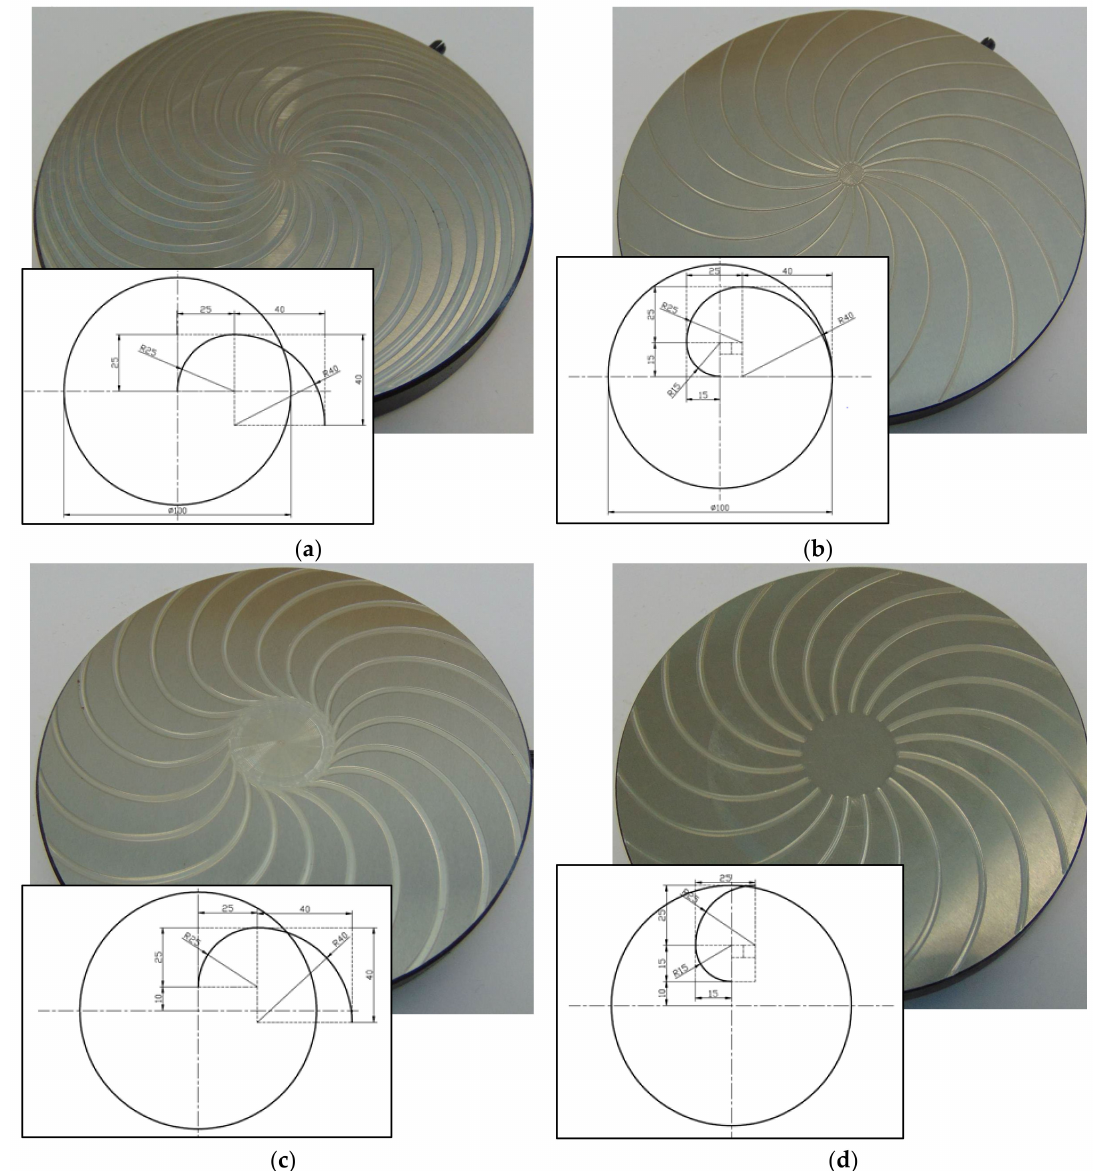
Figure 5. Views of discs of types 2 ( a ), 3 ( b ), 4 ( c ), and 5 ( d ) with dimensions of guiding